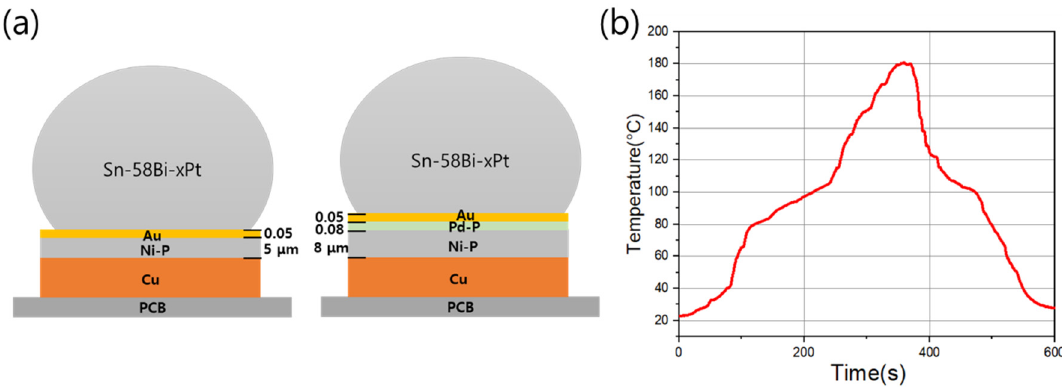
Figure 1. ( a ) Schematic diagram for ENIG and ENEPIG soldering configurations (not to scale); ( b ) reflow profile used for Sn-58Bi-xPt soldering reactions.